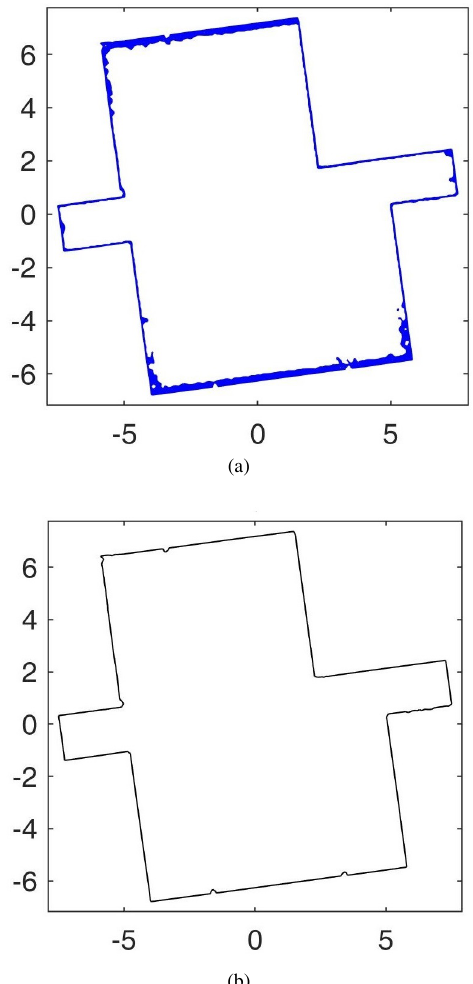
Figure 12: Selected polygonal